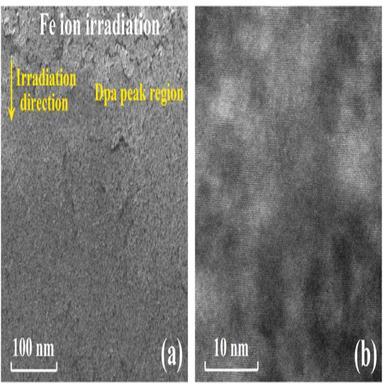
Cross-sectional TEM images of dpa peak region at different magnifications for individual Fe-irradiated Cu sample.